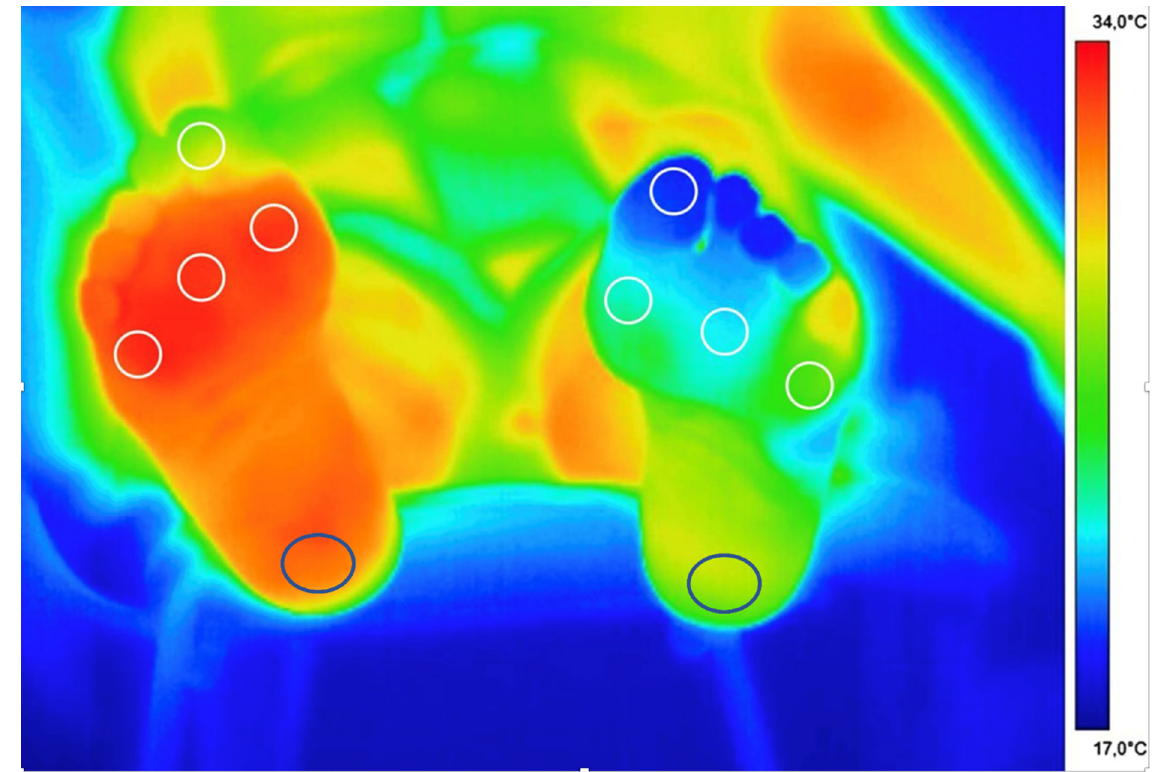
Figure 3. Regions of interest for temperature assessment.